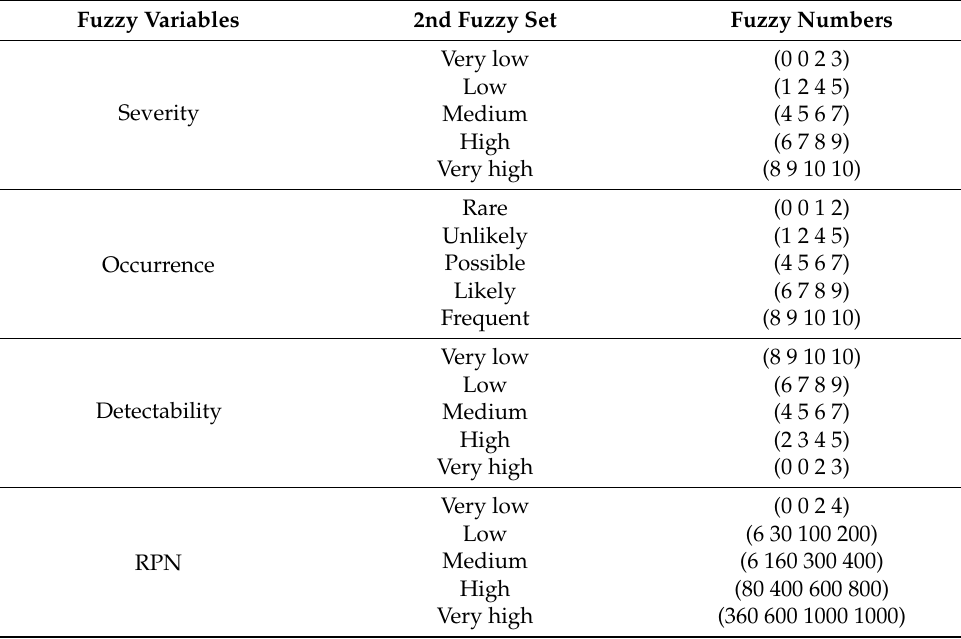
Table 5. Identified variables and the fuzzy set for fuzzy RPN